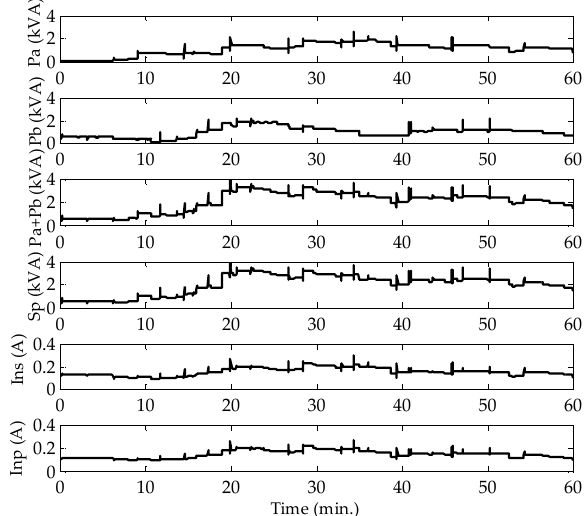
Figure 13. The powers and neutral currents of the transformer for the two-side broken neutral condition.